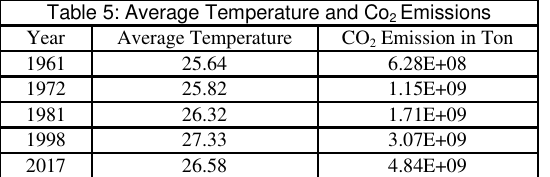
Fig. 12: Co 2 Emission from Energy Consumption Table 5: Average Temperature and Co 2 Emissions Year